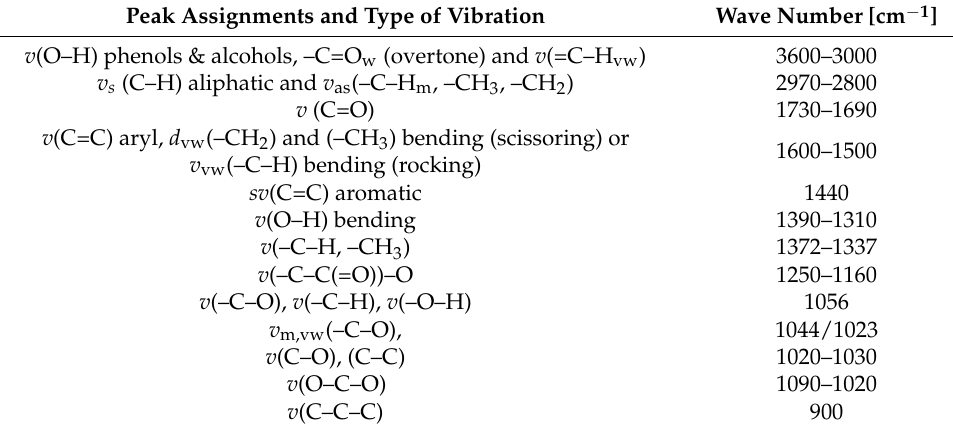
Figure 2. The FTIR spectra of common yarrow freeze-dried extracts. Table 1. Characteristic functional groups registered by FTIR analysis of extracts. Based on Refs. [47–52]. Peak Assignments and Type of